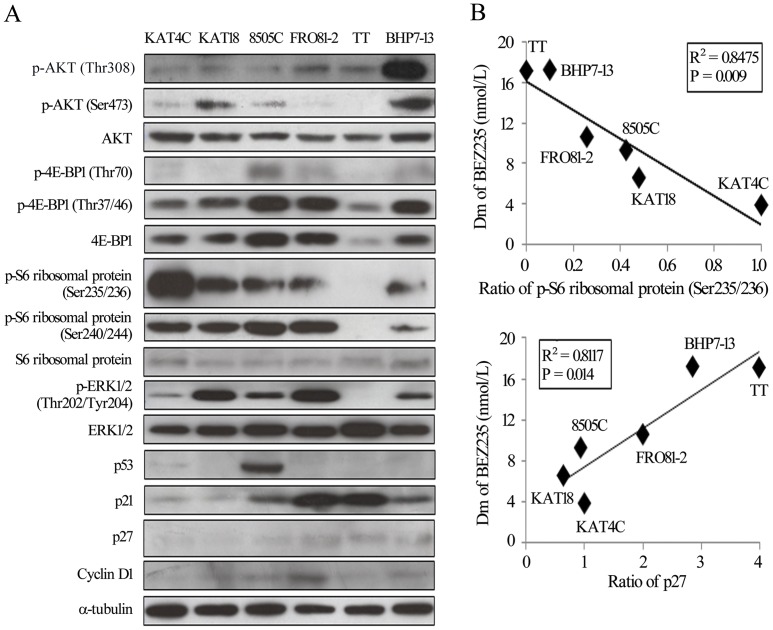
Susceptibility to BEZ235 correlates with baseline expression of p-S6 ribosomal protein (Ser235/236) and p27.A, the baseline levels of proteins associated with signaling transduction and cell cycle were evaluated by immunoblot. The sequence of proteins loaded was according to Dm. The expression of p-S6 ribosomal protein (Ser235/236) gradually decreased from KAT4C to BHP7-13, while p-27 showed the opposite order. The expression of the other proteins showed a random distribution. B, Band densities were imaged and quantified. Relationships between Dm and protein expression were analyzed using Pearson's correlation coefficients, and graphs were drawn using KAT4C. The expression of p-S6 ribosomal protein (Ser235/236) had a positive correlation, and p27 an inverse correlation, with sensitivity to BEZ235.